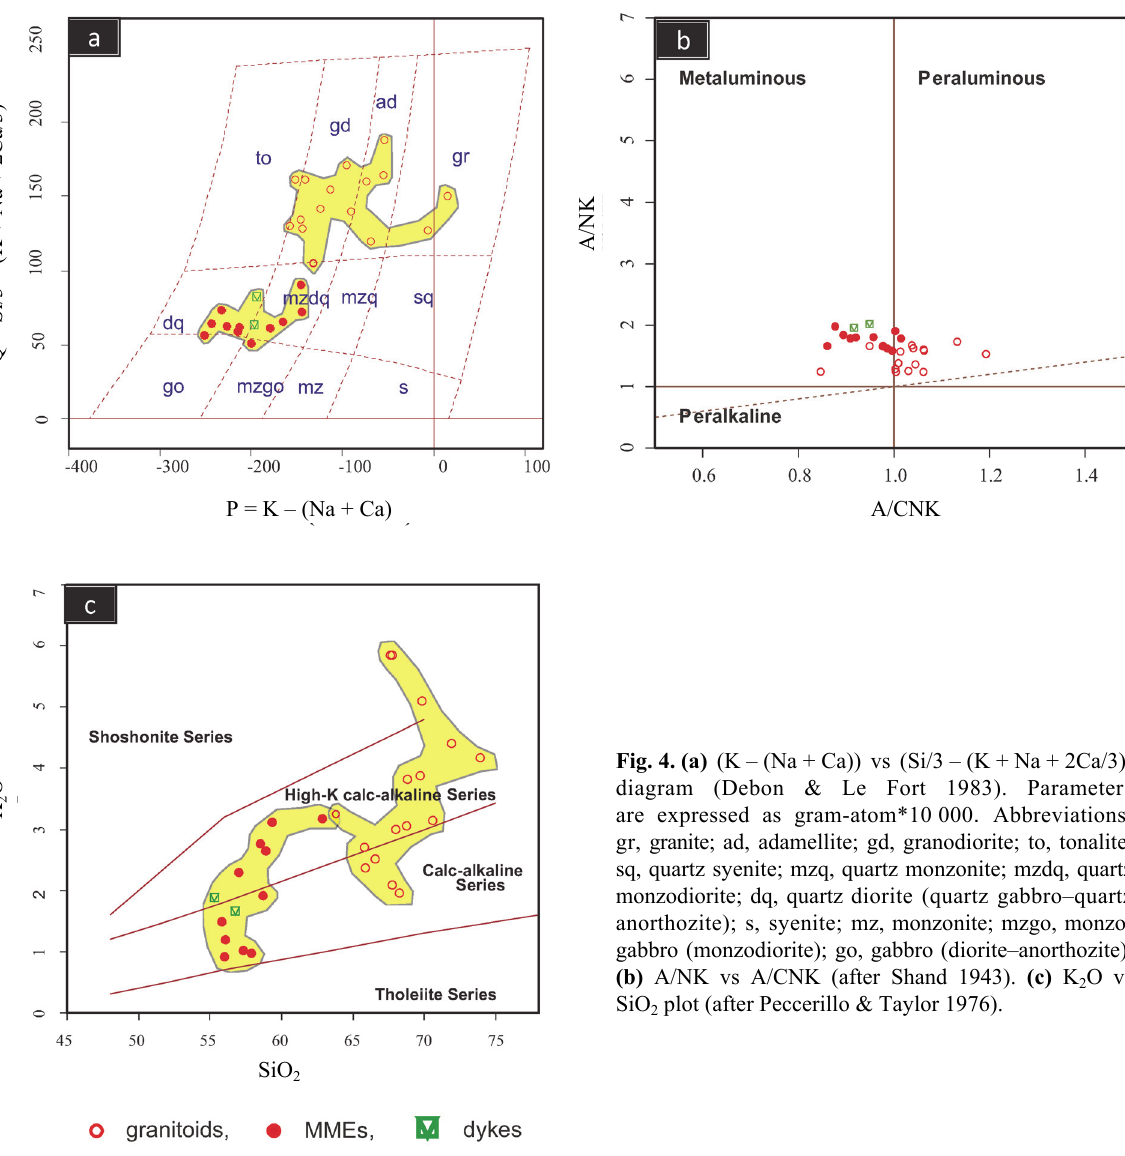
Fig. 4. (a) (K – (Na + Ca)) vs (Si/3 – (K + Na + 2Ca/3)) diagram (Debon & Le Fort 1983).